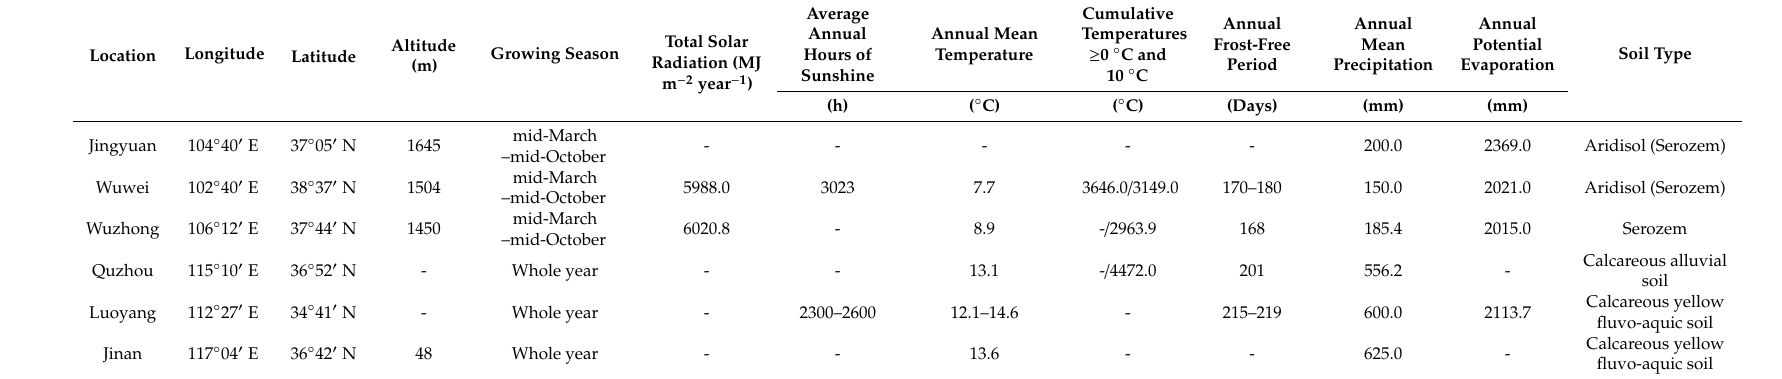
Table 1. Detailed available geographic coordinates and climatic conditions of the study sites.